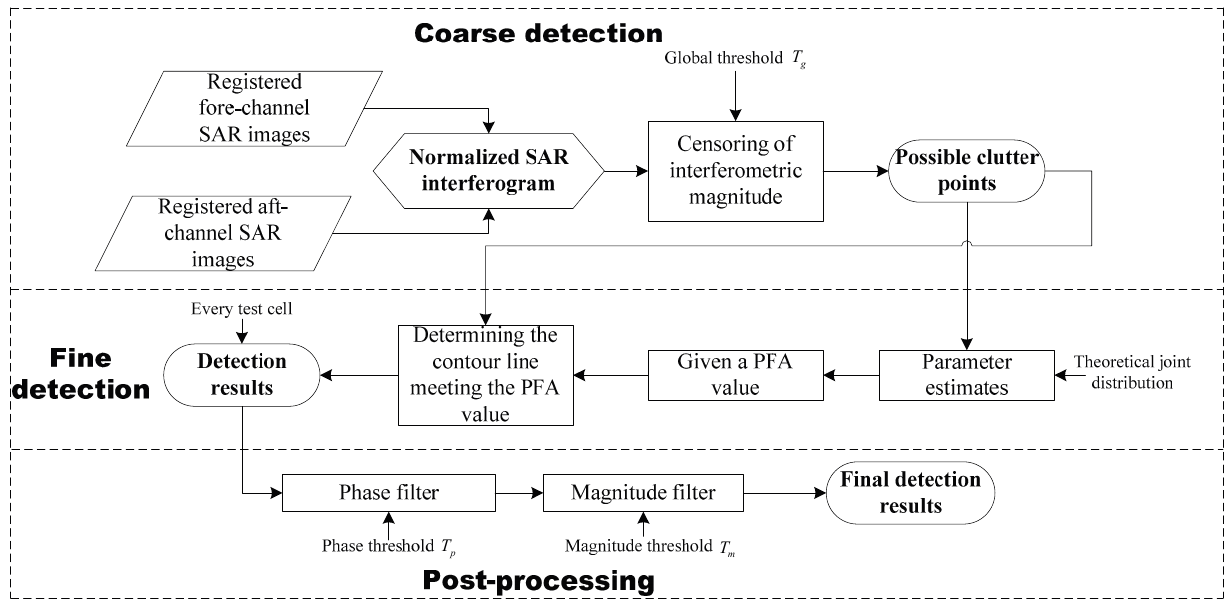
Figure 3. Flowchart of the proposed detection